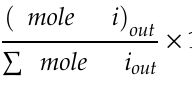
Figure S1: Additional SEM image and EDX mapping images of (a) LaCr 0.85 Ru 0.15 O 3 and (b) LaCo 0.85 Ru 0.15 O 3 , including elemental analysis